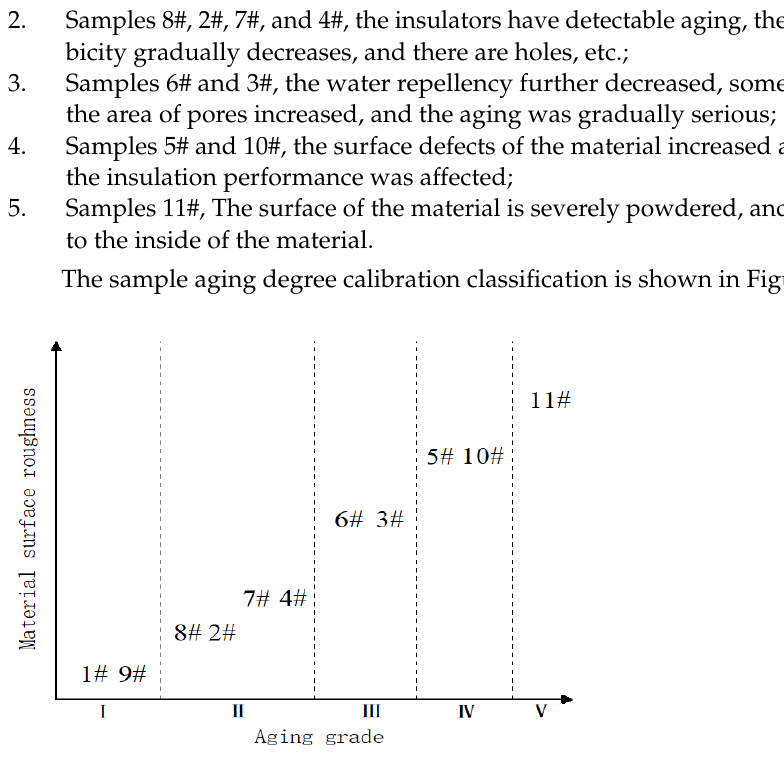
Figure 13. Classification diagram of sample aging degree calibration.